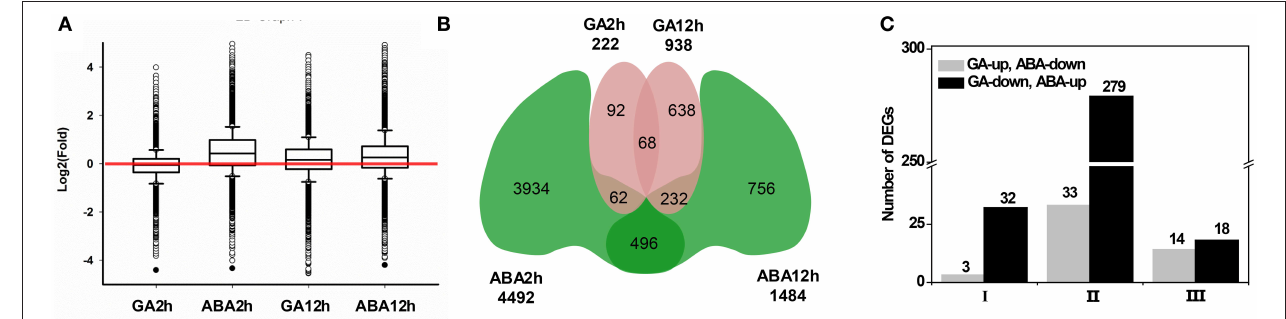
FIGURE 3 | Global comparisons of transcript profiles and DEGs in response to GA and ABA treatments. Petals of inflorescences at stage 3 were detached, placed on filter papers soaked with 3% sucrose (Control) or with hormone supplementation and were cultured as described in the text. Basal regions of the petals were collected after 2 or 12h of culture, followed by total RNA extraction for the subsequent RNA-Seq analyses and data mining. (A) Global transcript profiles at the 2 or 12h time point after culturing with hormone supplementation as indicated. Each box plot shows the